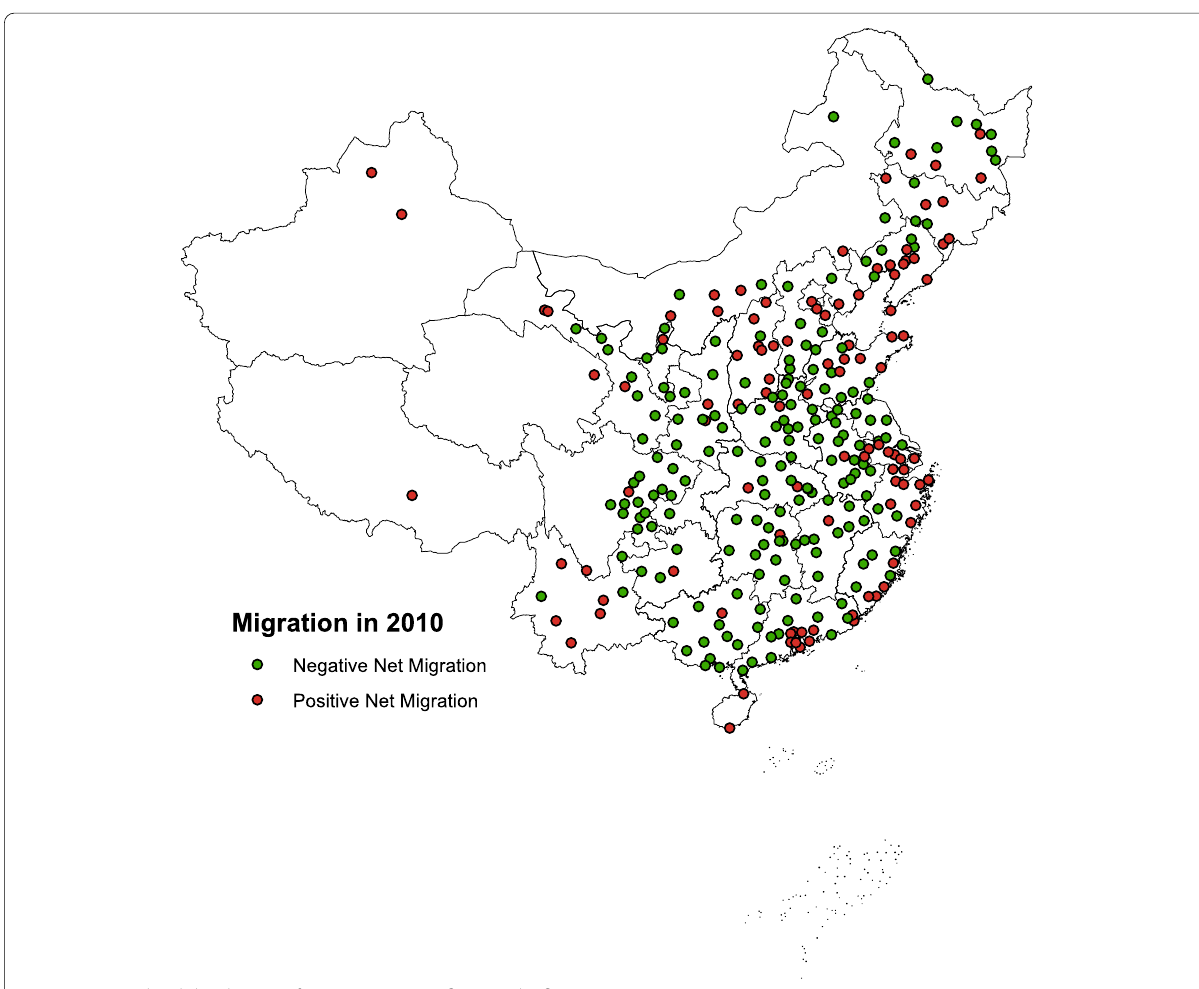
Fig. 3 Geographical distribution of migration net outflows and inflows in